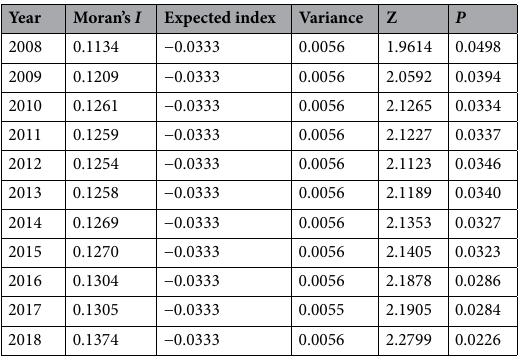
Table 4. Global Spatial Autocorrelation Analysis of GDP of China’s Provinces and Municipalities from 2008 to 2018.